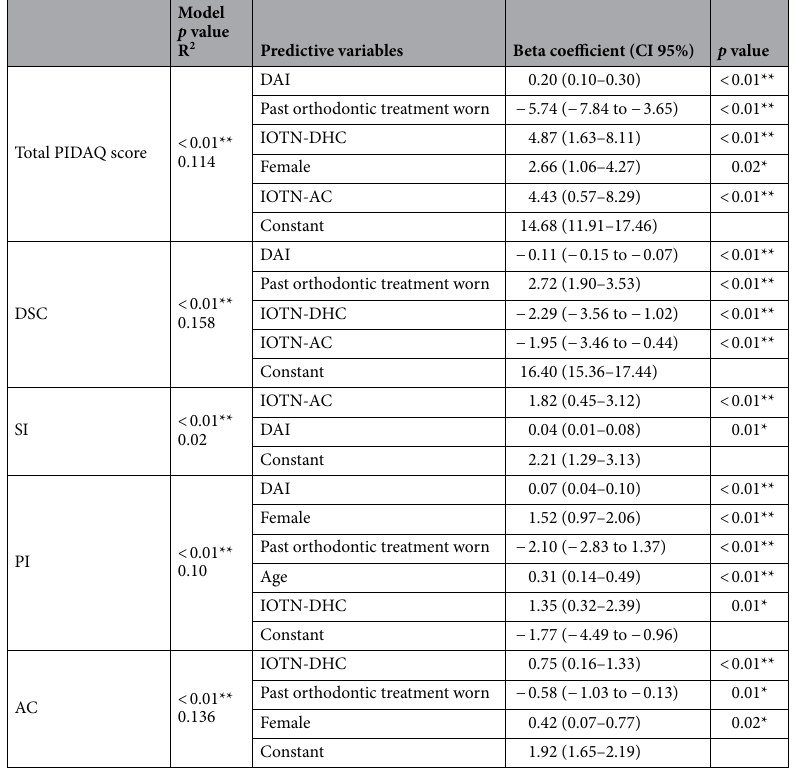
Table 5. Linear regression models estimated for the PIDAQ scores and its domains: DSC, SI, PI and AC and their predictive